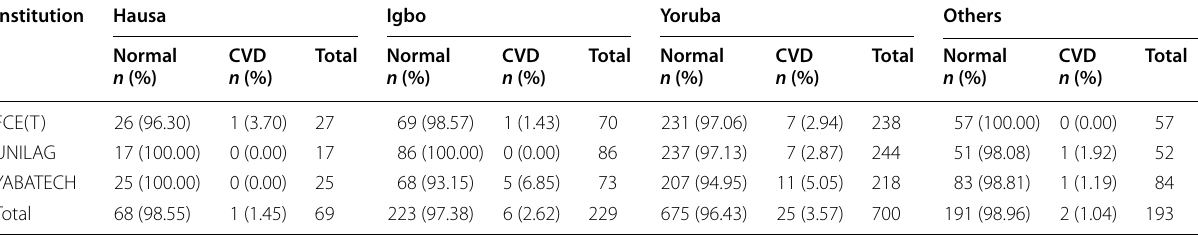
Table 4 Prevalence of colour vision deficiency among different ethnic groups of the students of FCE(T), UNILAG and YABATECH Institution Hausa